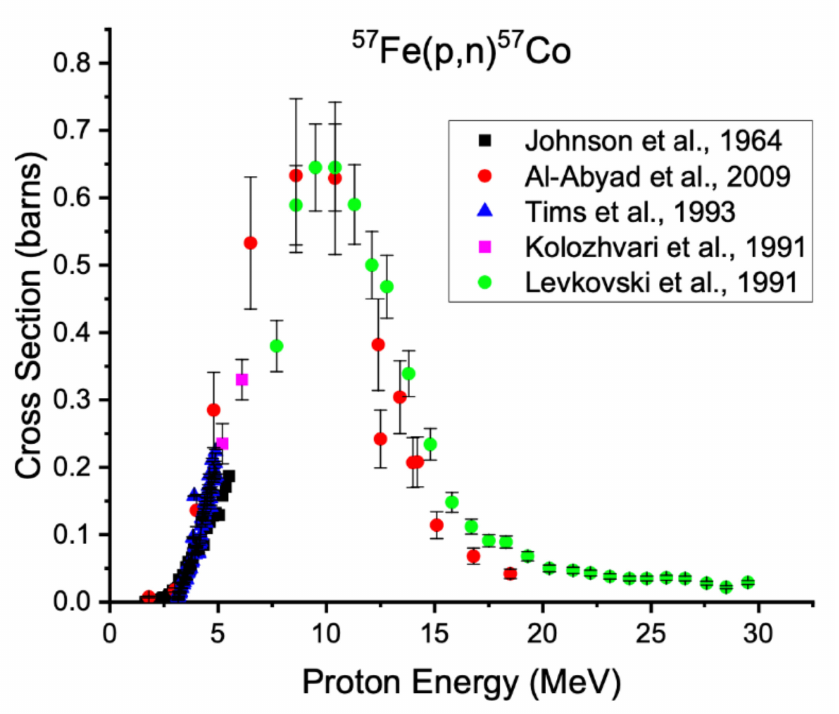
Figure 5. Measured excitation functions for the 57 Fe(p,n) 57 Co reaction